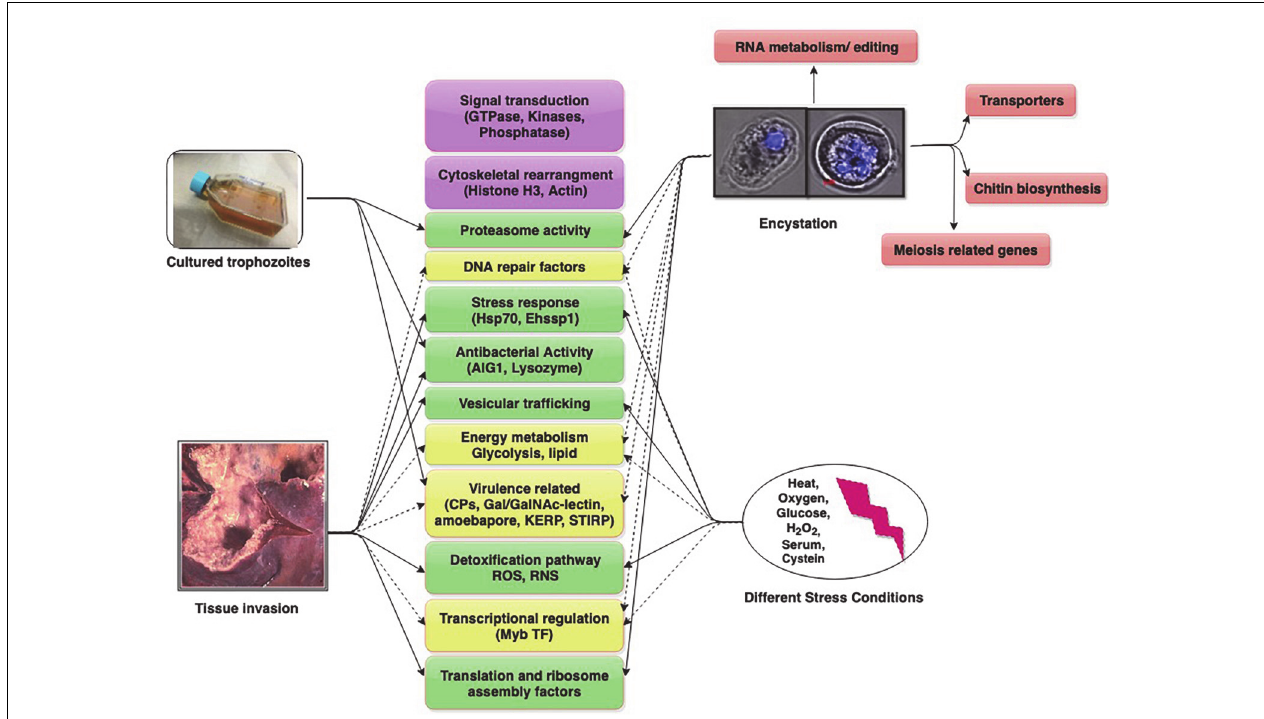
FIGURE 1 | Differentially expressed genes/pathways revealed from transcriptomic date. The major pathways are shown in boxes (with gene in parenthesis). Pathways scored in all studies (purple), three studies (yellow, dotted arrows), two studies (green), single study